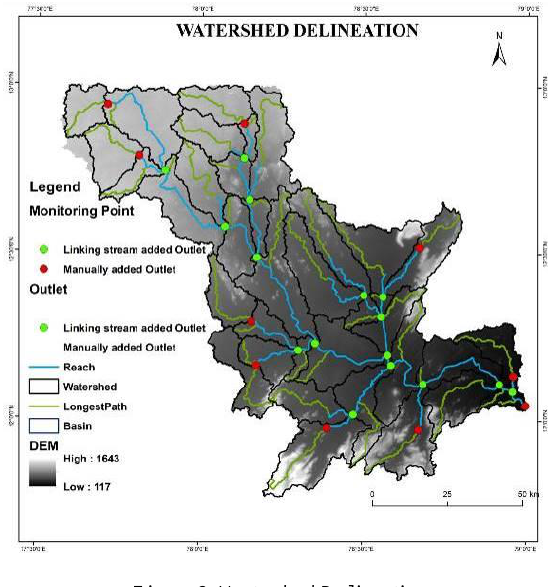
Figure 2. Watershed Delineation